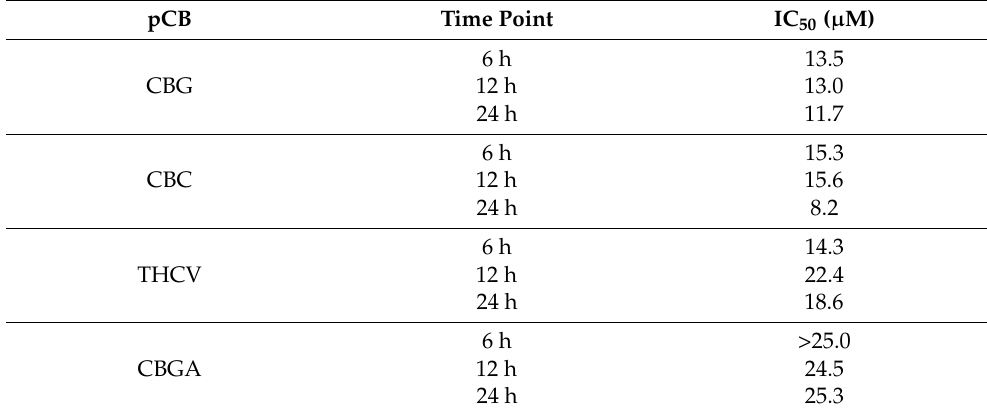
Table 1. IC 50 values ( µ M) of CBG, CBC, THCV and CBGA when tested at different time